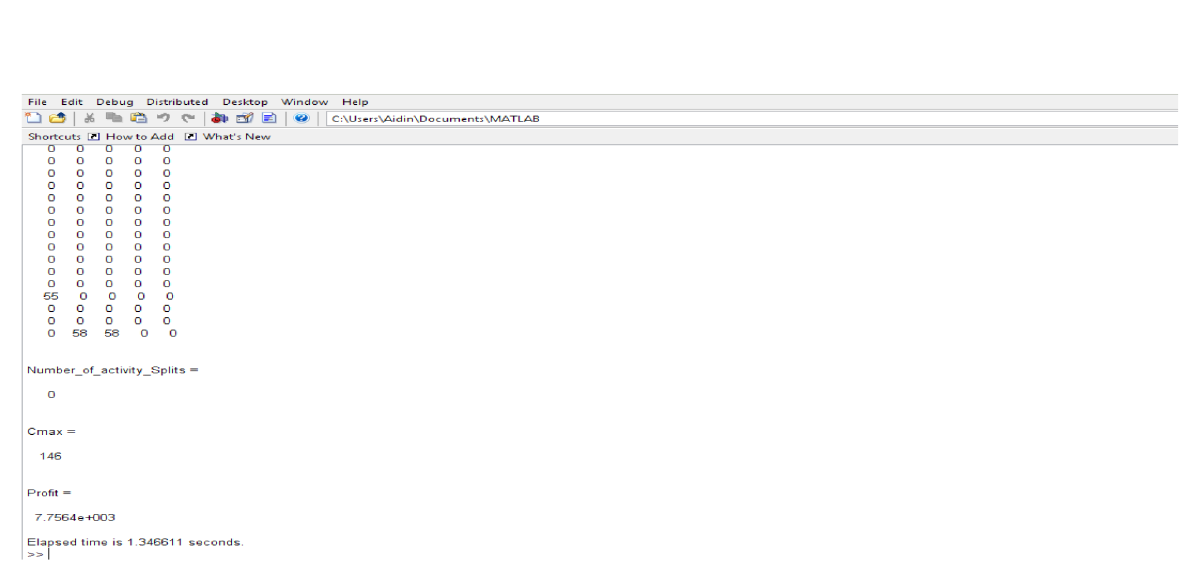
Figure 63. Results of solving the case study by the proposed method while Resource constraints are